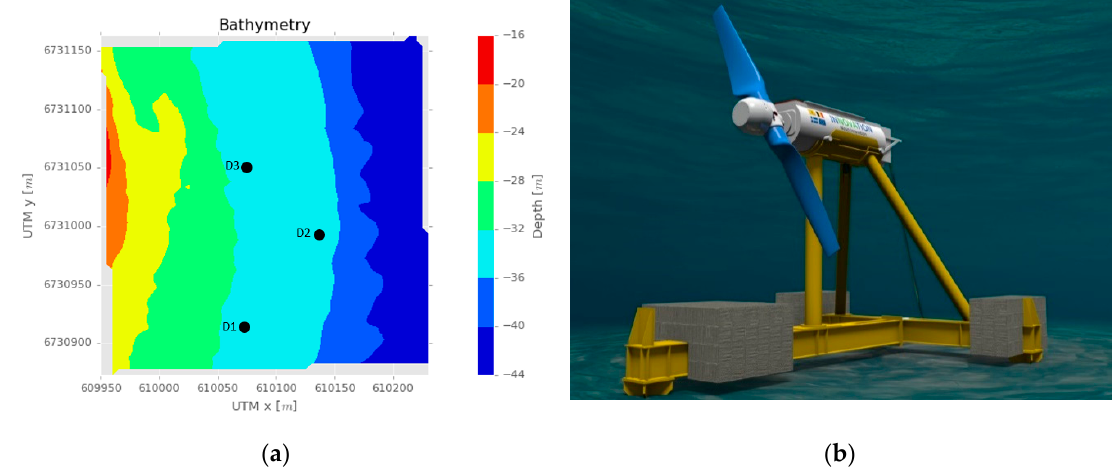
Figure 7. ( a ): Array of Three Turbines and bathymetry of the lease area; ( b ): Nova M100 tidal